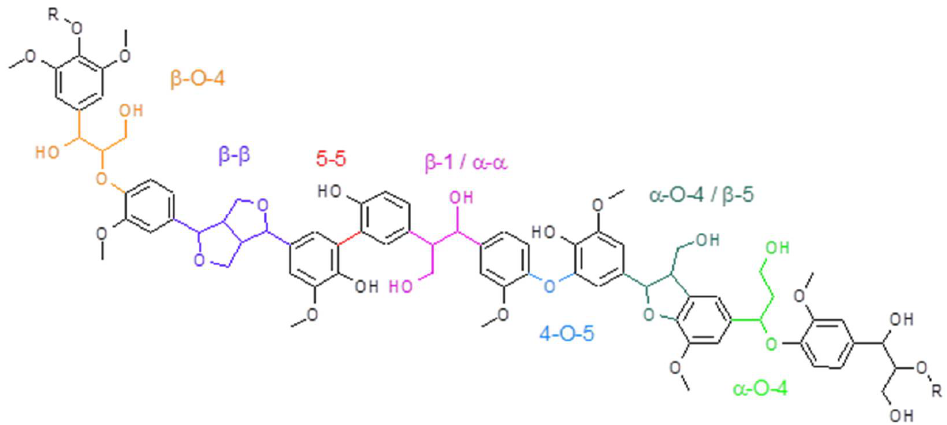
Figure 2. Representation of different bonds present in the structure of